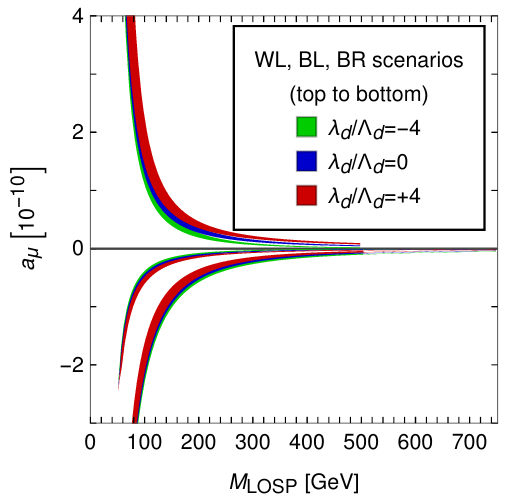
Figure 7. a (cid:22) in the WL (top three bands), BL (middle three bands), BR (bottom three bands) scenarios. The three bands correspond to three di(cid:11)erent choices of (cid:21) d , (cid:3) d , as appropriate; the width of the bands is de(cid:12)ned as in (cid:12)gure